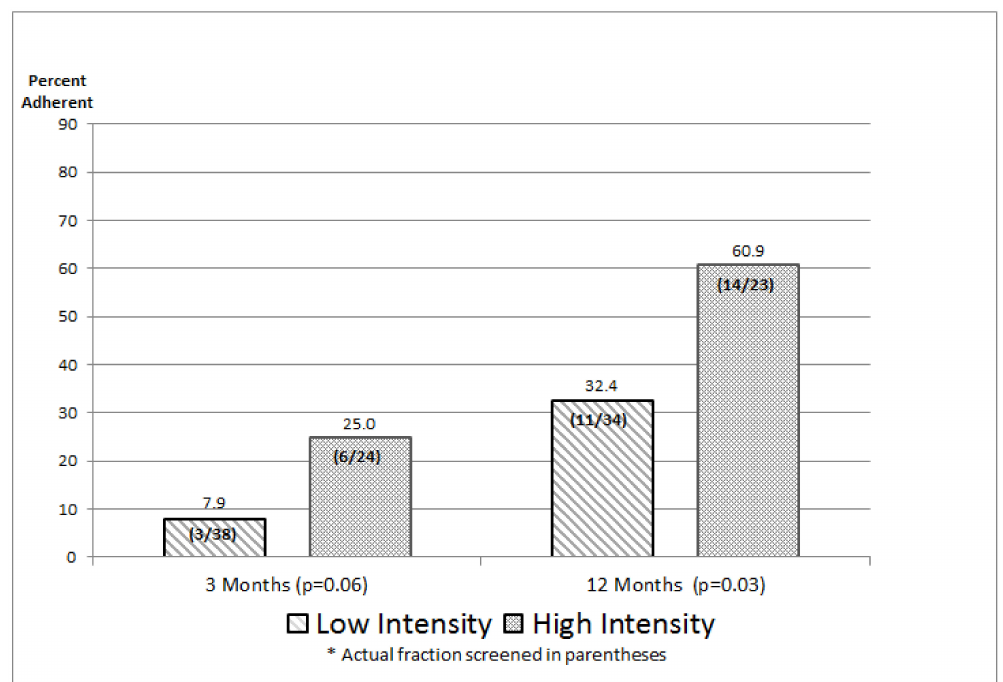
Figure 4. Intervention Impact on Mammography Screening Adherence Rates for